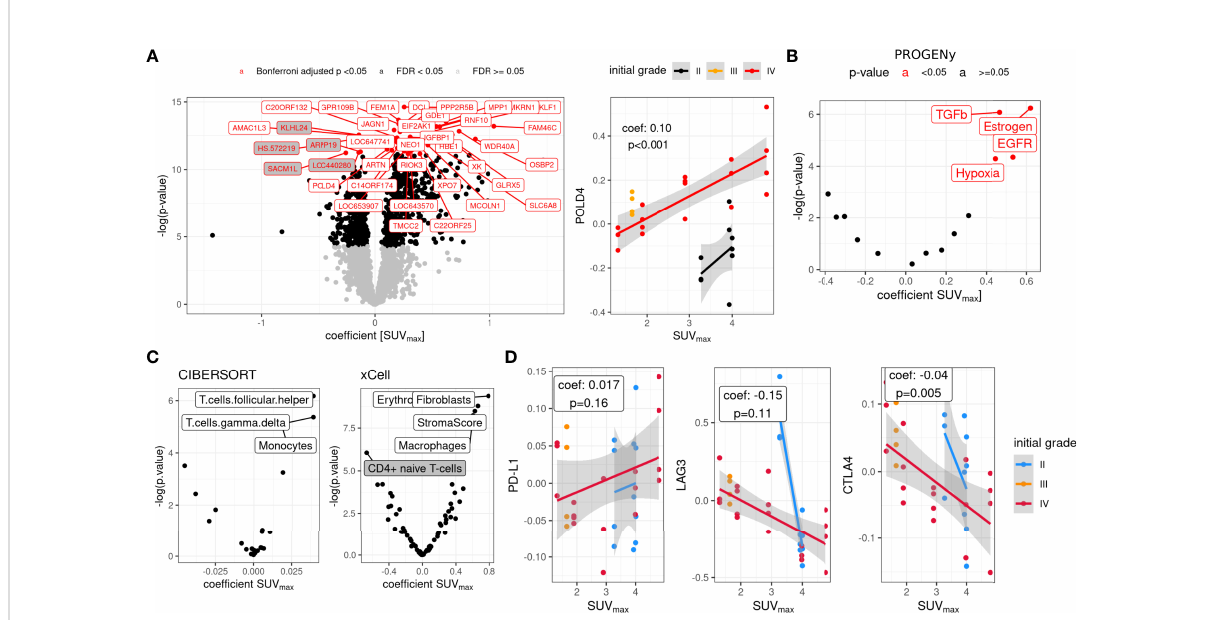
FIGURE 6 Whole-blood transcriptome associations with SUVmax in the rHGG cohort. (A) Genes associated with SUVmax, adjusted for initial WHO grade (most variable 10% of genes: median absolute deviation, gray background, coef fi cient < 0) and representative data for POLD4 (right) with linear fi ts. (B) PROGENy estimated pathway activity from transcriptome data (non-adjusted p-value). (C) CIBERSORT and xCell estimated cell fractions associated with SUVmax (adjusted for initial tumor grade, z-scaled data, non-adjusted p-value). (D) Association of SUVmax with immune checkpoint gene expression (linear mixed models). n = 9 patients. rHGG, recurrent high-grade